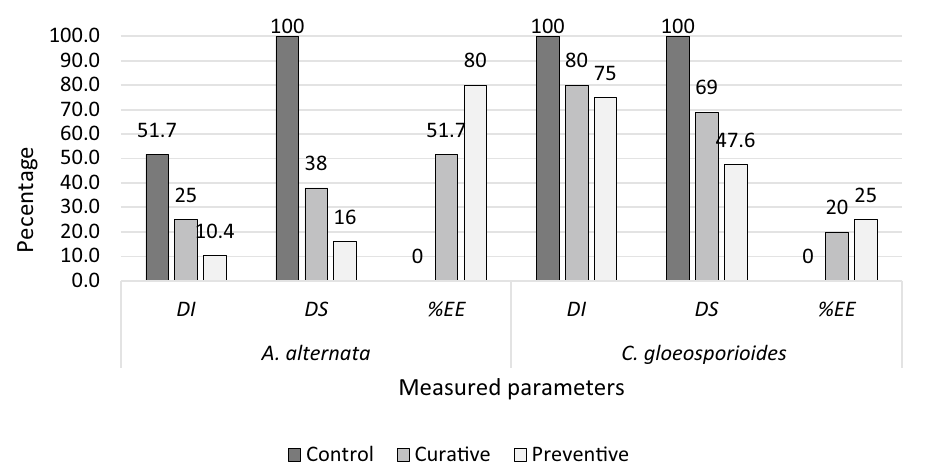
Figure 5. Curative and preventive measured parameters of PJ-WS-LE extract against A. alternata and C. gloeosporioides inoculated in mango samples. Disease incidence (DI), disease severity (DS), and percent plant extract efficacy